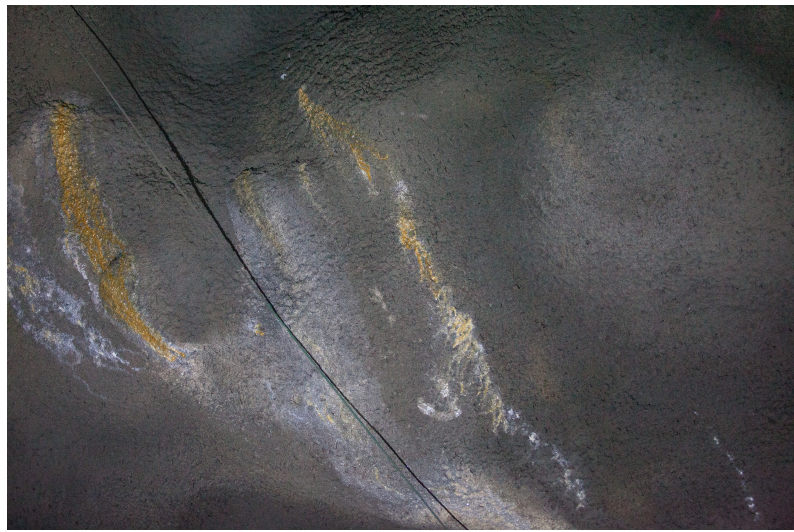
Figure 5. Examples of leaching of the shotcrete in a hard rock tunnel, from Sjölander and Ansell